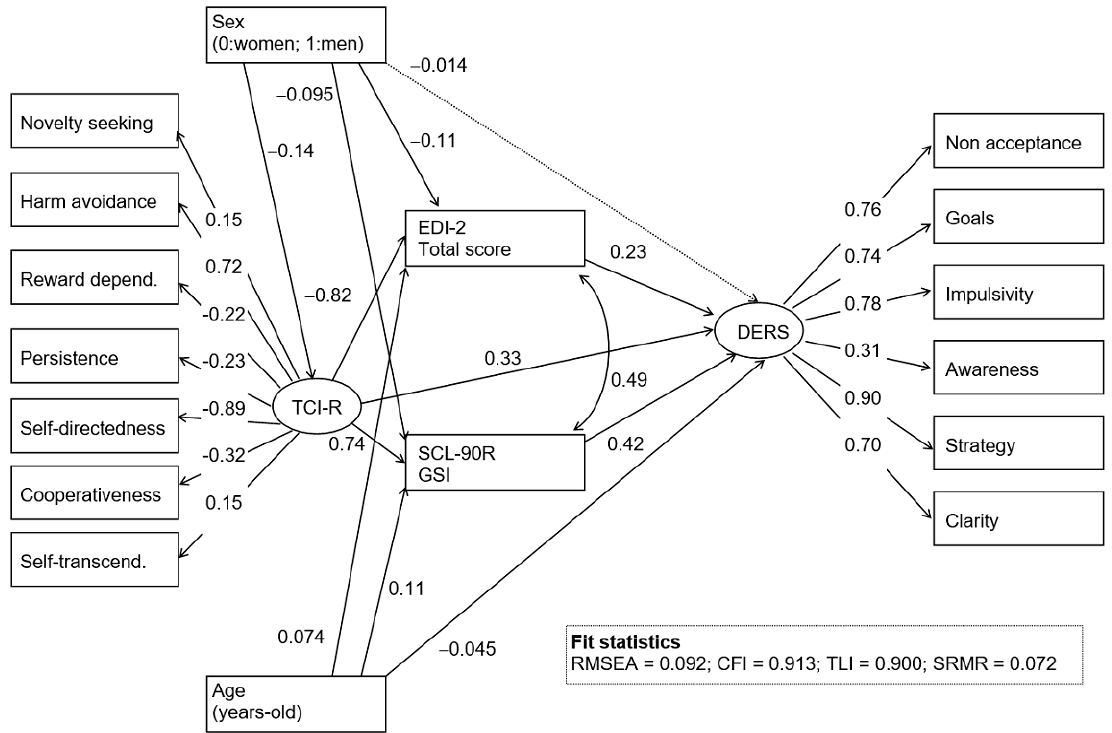
Figure 2. SEM: Standardized coefficients (ED subsample; n = 718). Continuous line: Significant parameter (0.05 level). Dash line: Nonsignificant parameter. GSI: Global Severity Index.